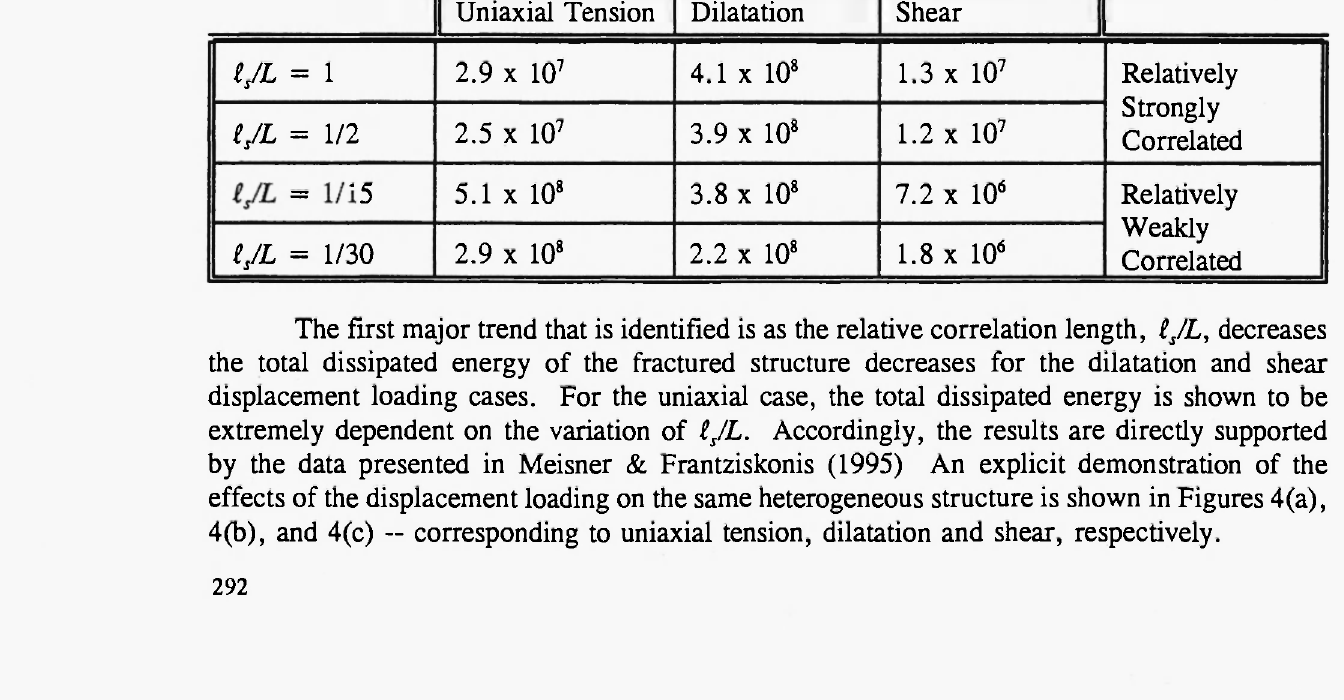
Figure 2: Example of the 60x60 lattice structure. Table 2. Total Dissipated Energy (60 χ 60 lattice), C.O.V. =